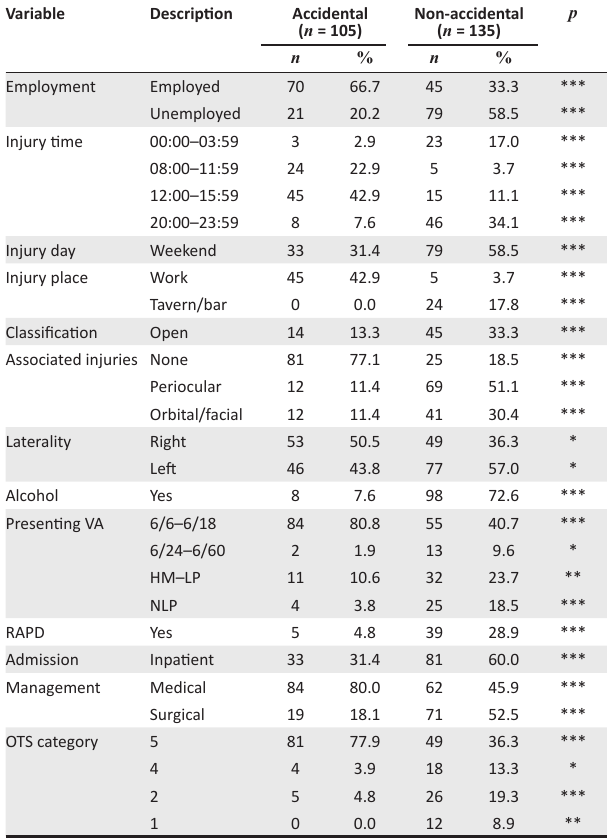
TABLE 1: Comparison of accidental versus non-accidental ocular trauma ( n = 240). Variable Description